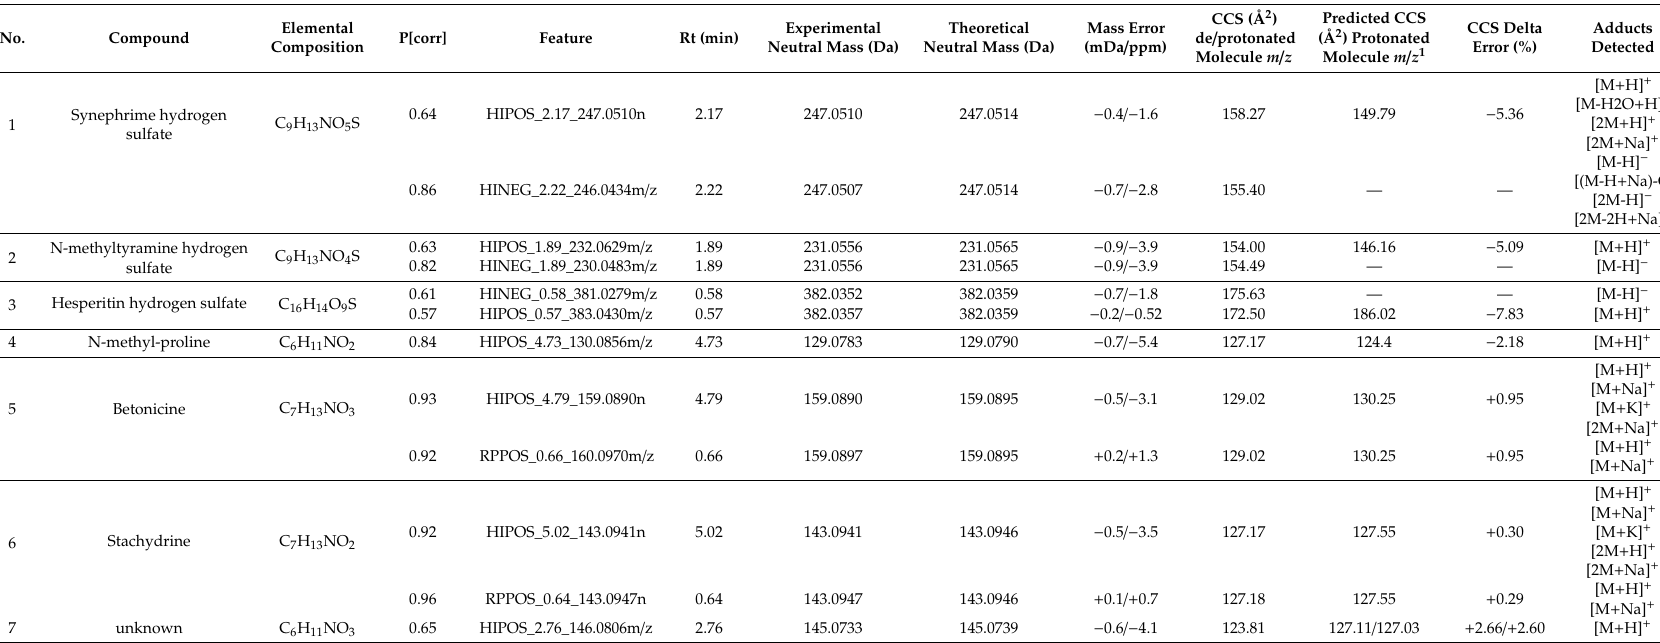
Table 2. Compound list obtained from the untargeted metabolomic approach for determining acute biomarkers of orange